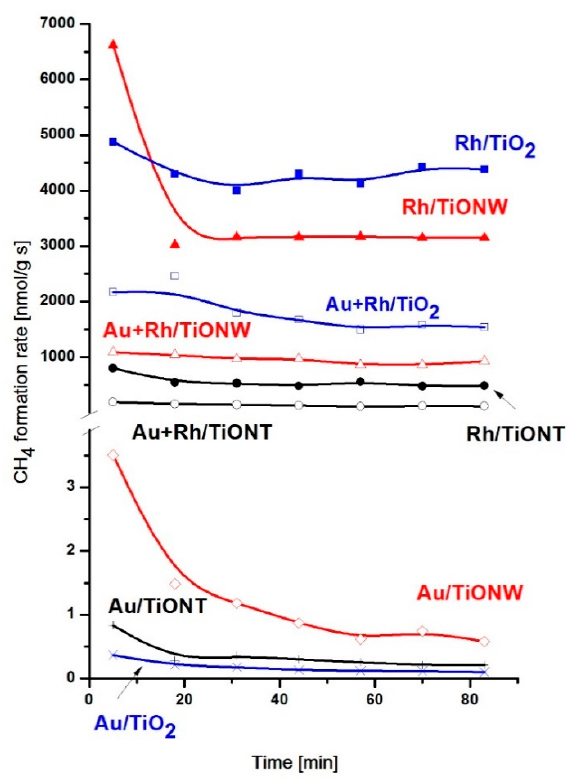
Figure 6. Rate of methane formation over Rh / TiO 2 , Rh / TiONW, Rh / TiONT, Au–Rh / TiO 2 , Au–Rh / TiONW, Au–Rh / TiONT, Au / TiO 2 , Au / TiONW, Au / TiONT catalysts at 493 K.